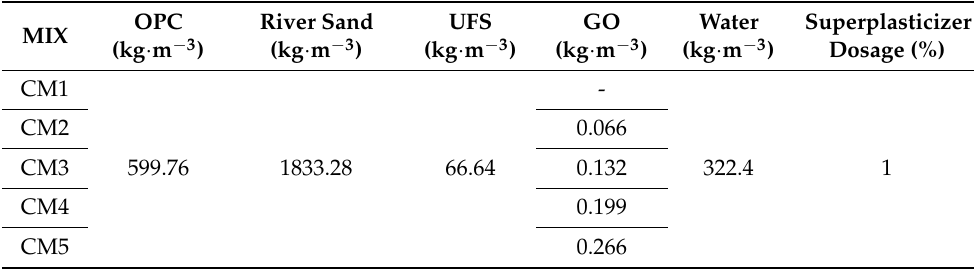
Table 2. Composition of